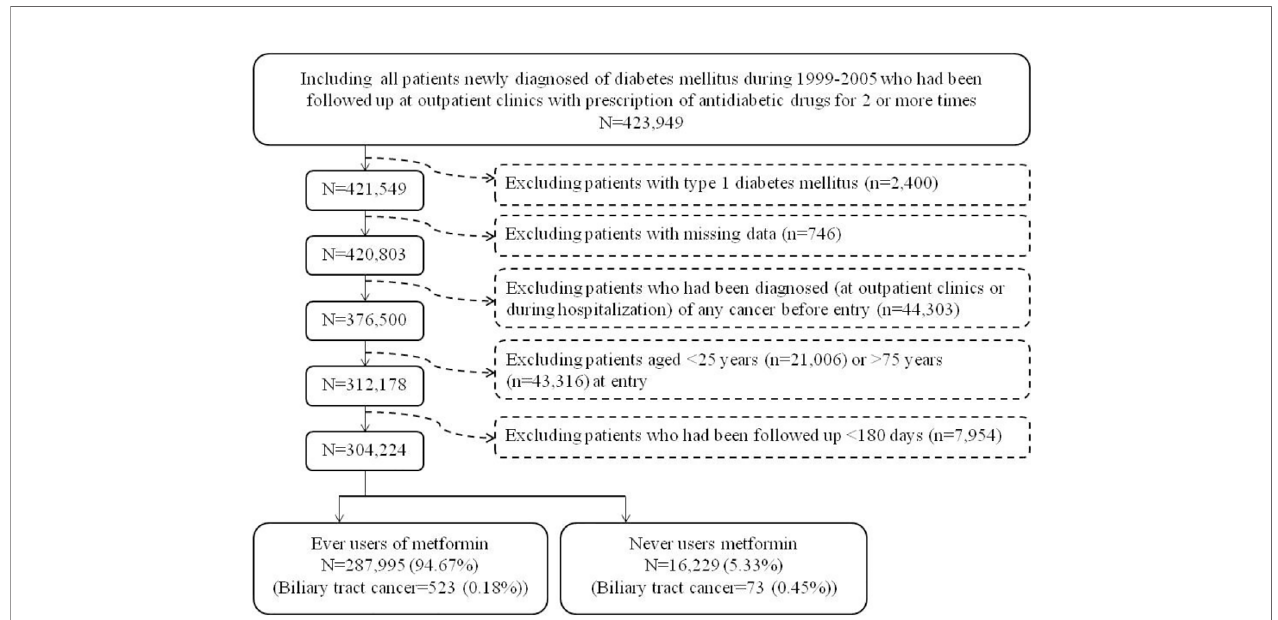
FIGURE 1 | The procedures in creating the unmatched original cohort of ever and never users of metformin by using the reimbursement database of the National Health Insurance of